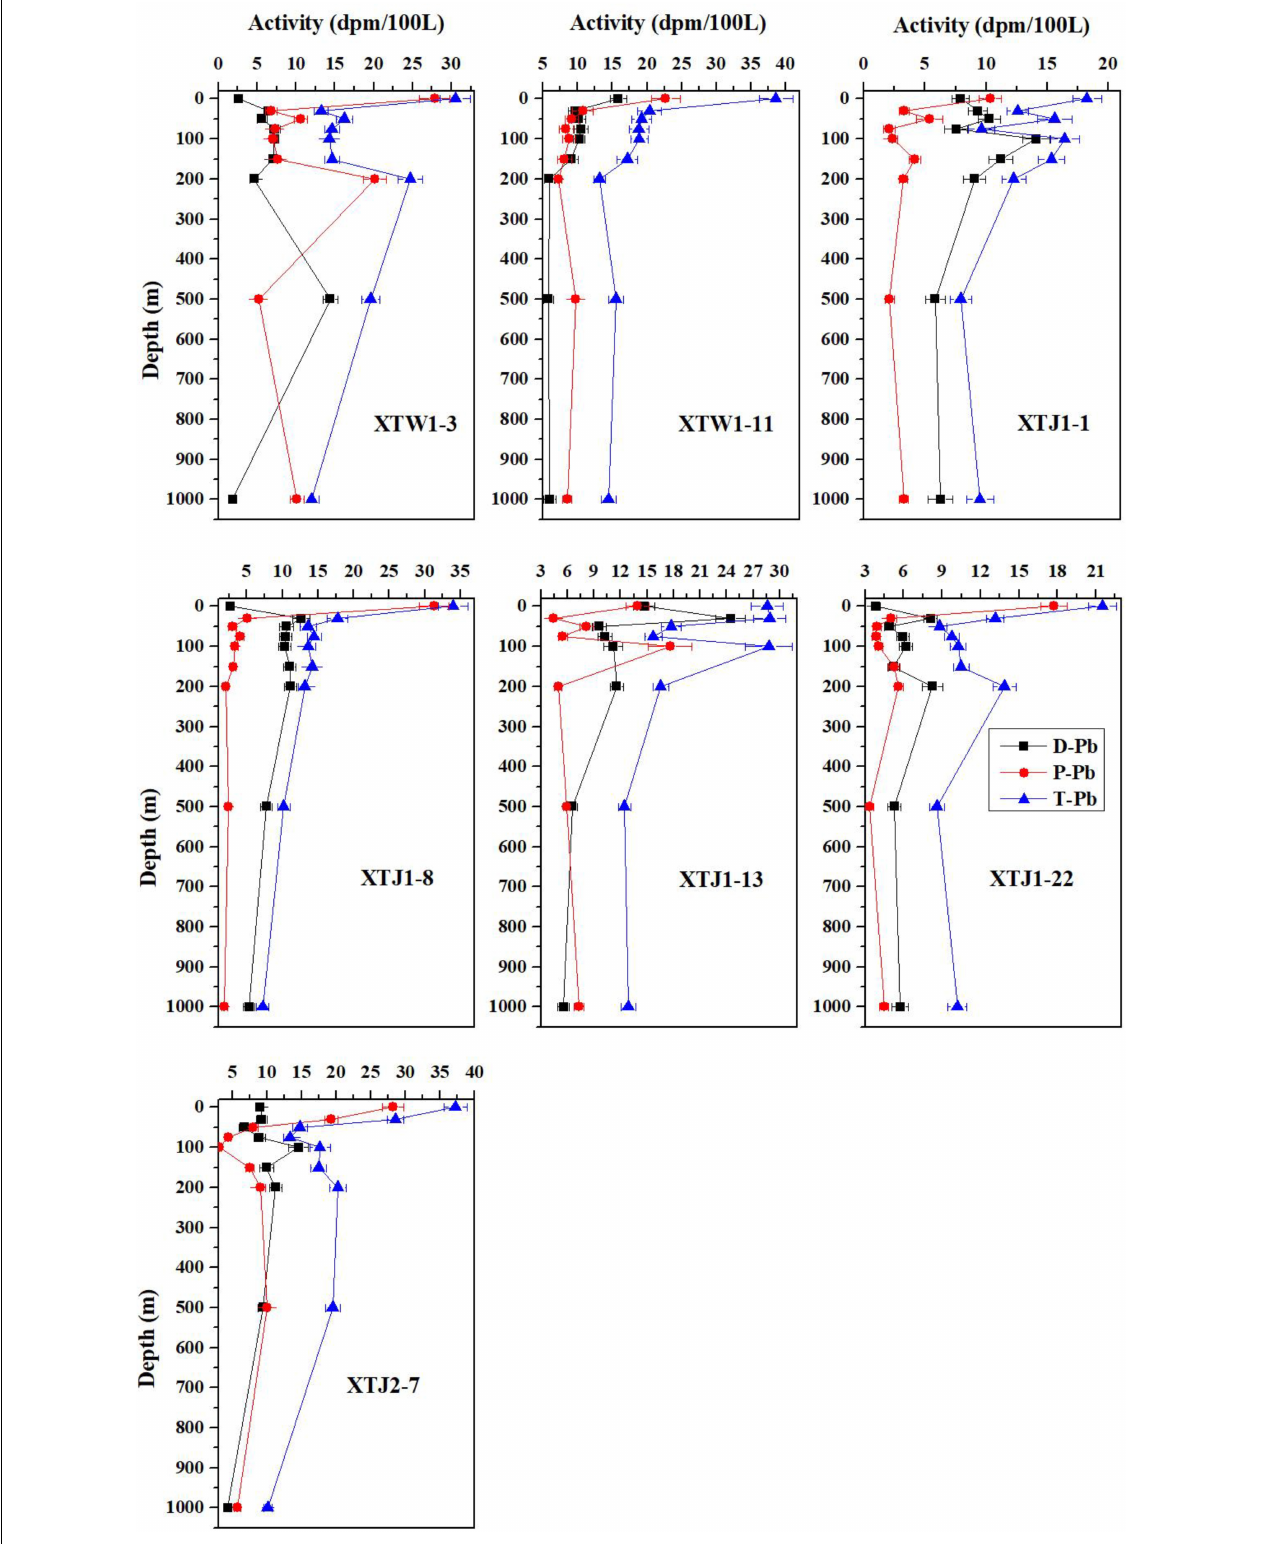
FIGURE 5 | Vertical distributions of particulate (P), dissolved (D), and total (T) 210 Pb activities in the water column at each station in the w-NPO.